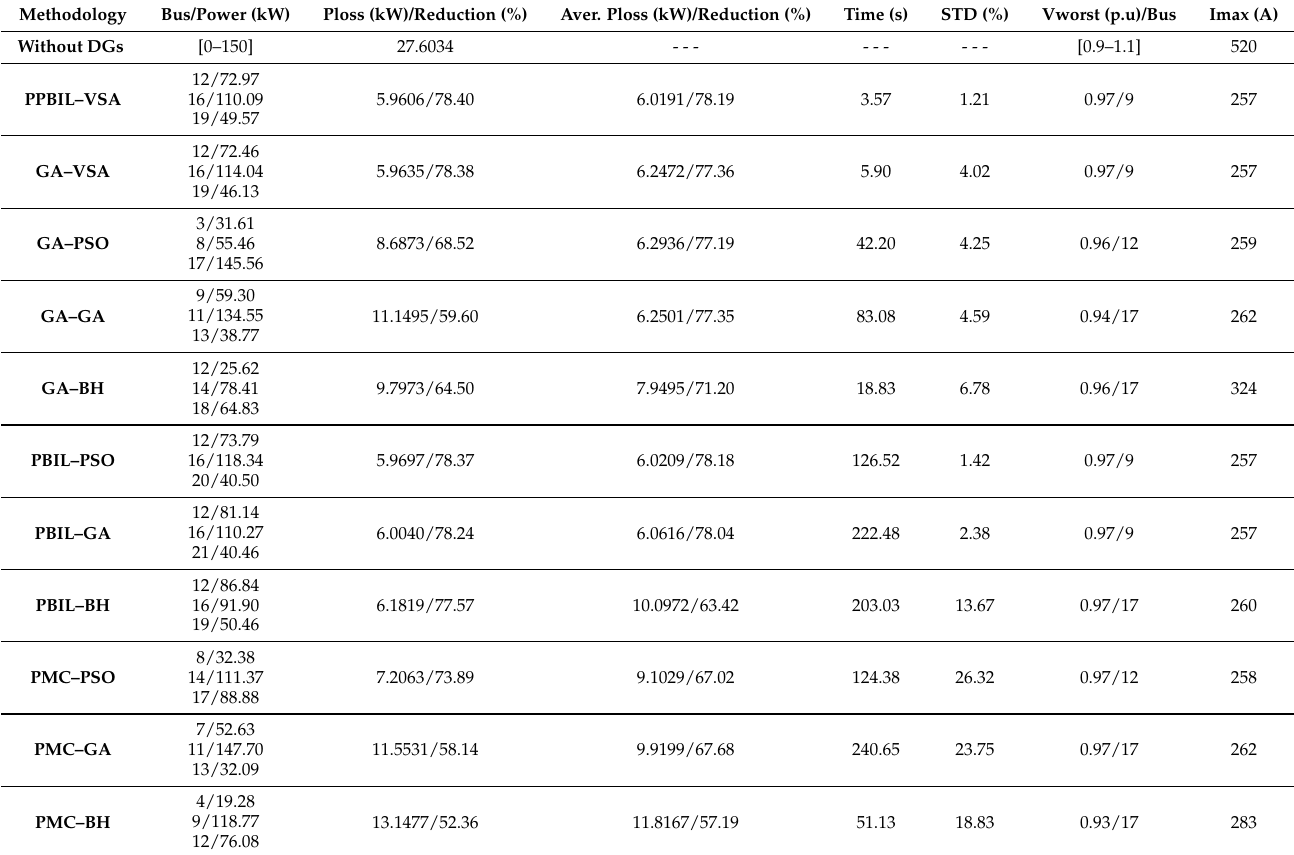
Table 2. Simulation results obtained by the different methodologies in the 21-bus test